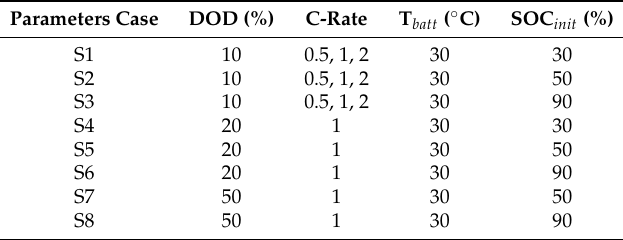
Table 4. Synthetic drive cases at 30 ◦ C in various SOC, Depth of Discharge (DOD) and